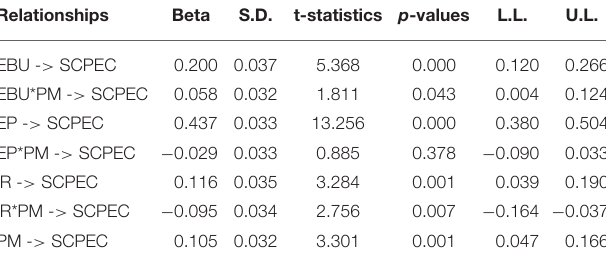
TABLE 5 | Hypothesis results (Path